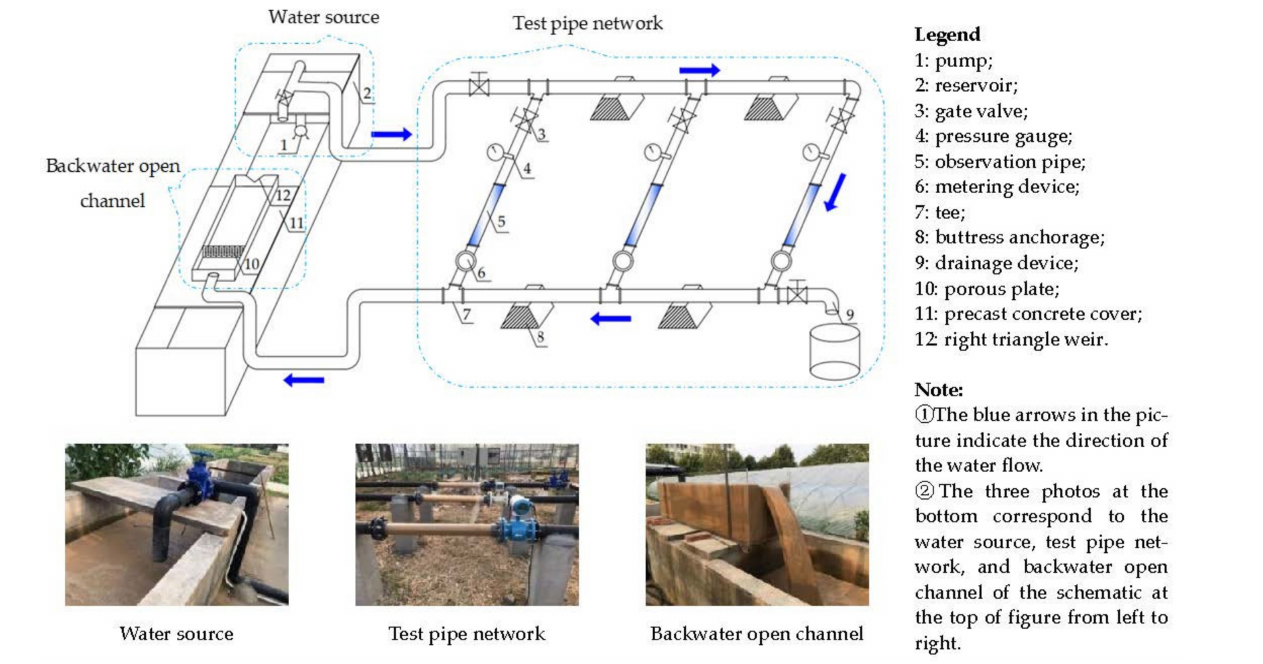
Figure 2. Schematic diagram of the test device.